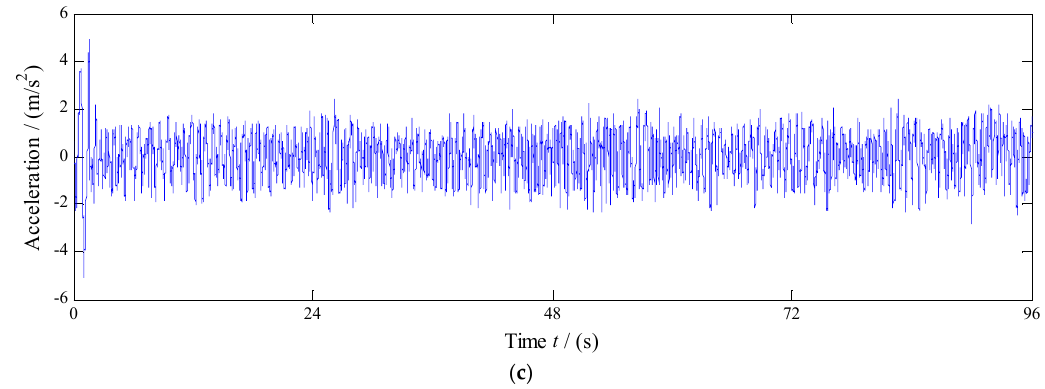
Figure 9. The measured cab floor vertical acceleration signals under the sand road for: ( a ) v = 80 km/h; ( b ) v = 60 km/h; and ( c ) v = 40 km/h.